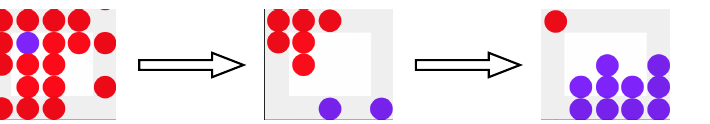
Figure 2. Flow of spikes inside the kernel during three different moments (positive spikes in red and negative spikes in purple).